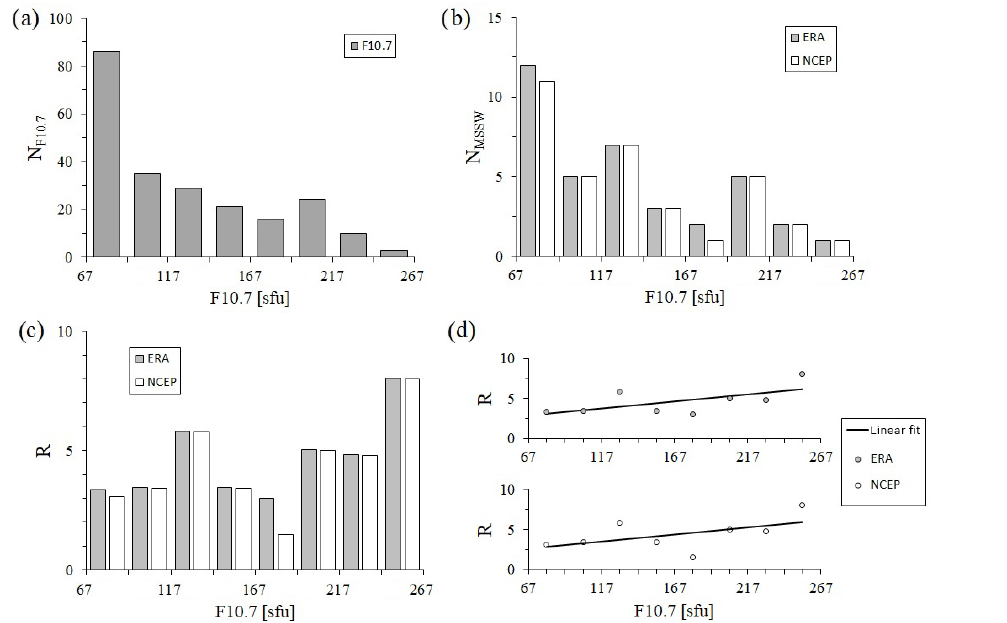
Figure 1. (a) Monthly mean F10.7 values between 1958 and 2013 of 4 months between December and March; (b) the number of MSSWs depending on F10.7 values; (c) normalized occurrence rate of MSSWs depending on F10.7 values; (d) correlation analysis for the normalized occurrence rate of MSSWs and F10.7